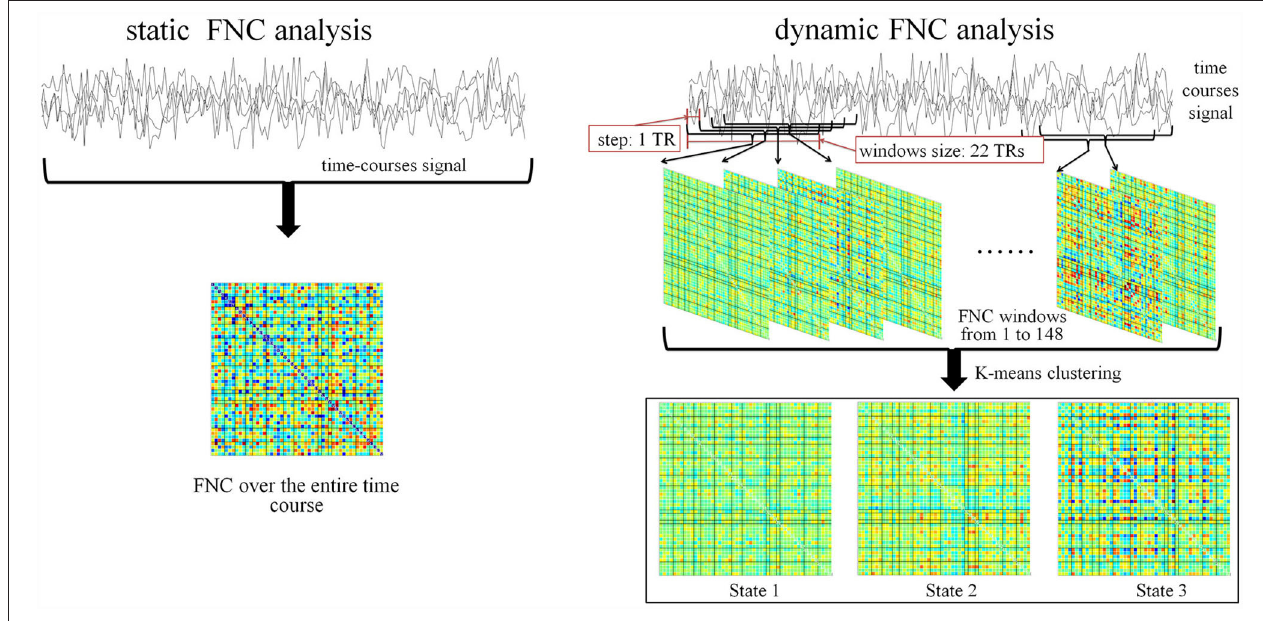
FIGURE 5 | Pipeline for static FNC and dynamic FNC analysis.